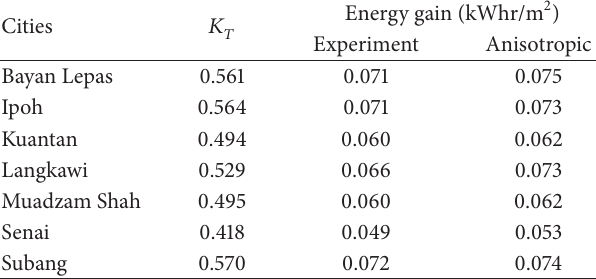
Table 3: Energy gain based on experimental curve and isotropic model on midday segment.